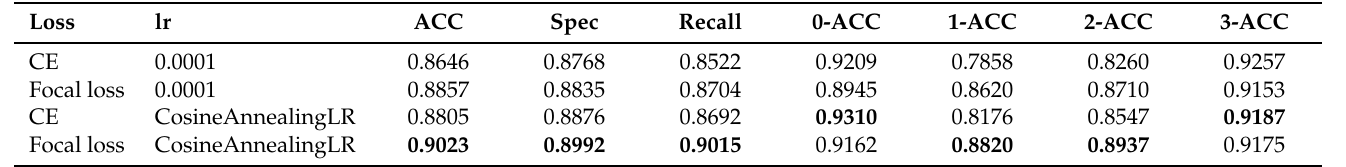
Table 5. Comparison table of experimental results of WSAC-ResNet combination using optimized loss function and changing learning